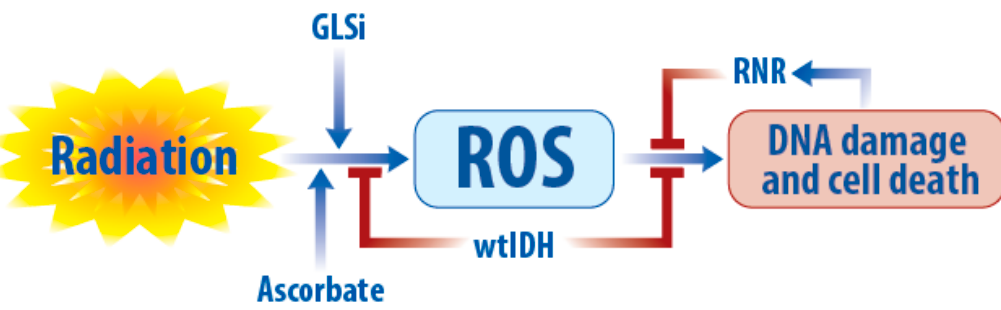
Figure 3. Summary of metabolic targeting in radio-sensitizing of GBM. Radio-sensitivity can be improved by depletion of glutathione (GLSi) and NAD+ (ascorbate and PARPi), and inhibition of IDH (wtIDHi or mIDHi) and deoxyribonucleotide (RNRi) to finally induce DNA damage and cell death.